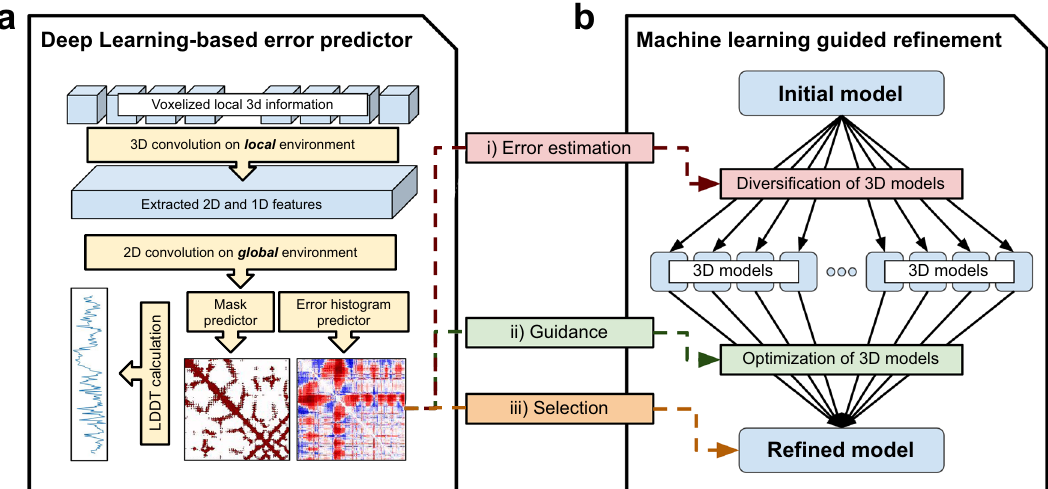
Fig. 1 Approach overview. a The deep learning network (DeepAccNet) consists of a series of 3D and 2D convolution operations. The networks are trained to predict (i) the signed C β – C β distance error distribution for each residue pair (error histogram or estogram in short), (ii) the native C β contact map with a threshold of 15 Å (referred to as mask), (iii) the C β l-DDT score per residue; C α is taken for GLY. Input features to the network include: distance maps, amino acid identities and properties, local atomic environments scanned with 3D convolutions, backbone angles, residue angular orientations, Rosetta energy terms, and secondary structure information. Multiple sequence alignment (MSA) information in the form of inter-residue distance prediction by the trRosetta network and sequence embeddings from the ProtBert-BFD100 model (or Bert, in short) are also optionally provided as 2D features. Details of the network architecture and features are provided in Methods. b The machine learning guided re fi nement protocol uses the trained neural networks in three ways; the estimated C β l-DDT scores are used to identify regions for more intensive sampling and model recombination, the estimated pairwise error distributions are used to guide diversi fi cation and optimization of structure(s), and fi nally the estimated global C β l-DDT score, which is mean of per- residue values, to select models during and at the end of the iterative re fi nement process.